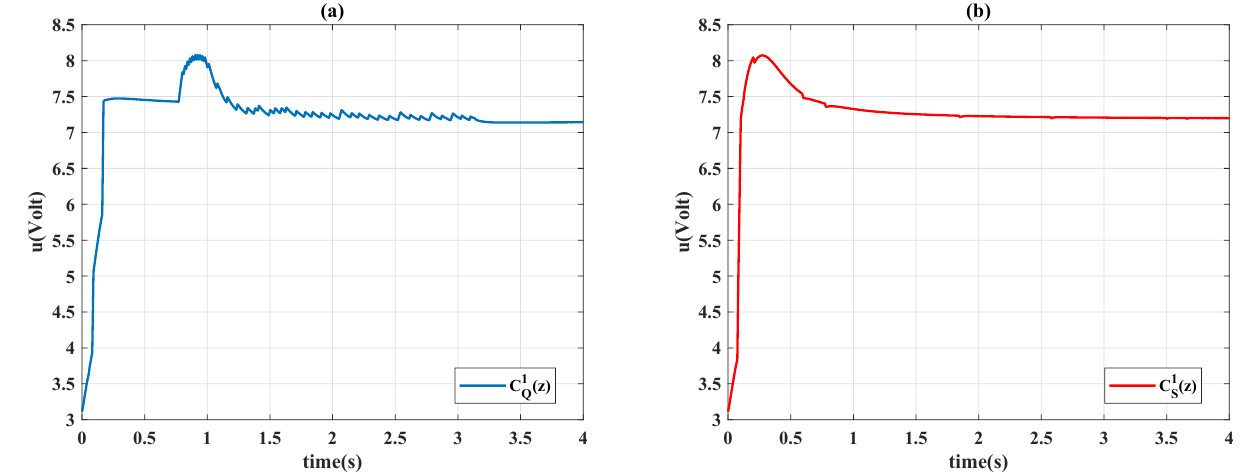
( z ) ; ( b ) Sarsa C 1 ( z ) . Q S